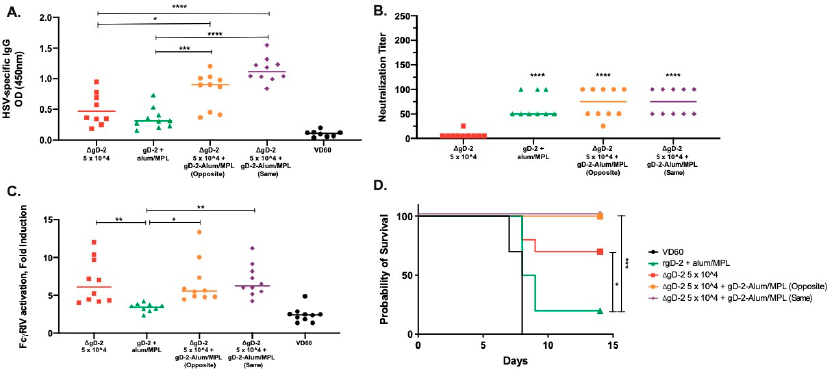
Figure 6. The generation of neutralizing antibody enhances protection by low-dose ∆ gD-2. Female C57BL / 6 mice were subcutaneously vaccinated twice, three weeks apart with 5 × 10 4 pfu / mouse of ∆ gD-2, 5 µ g gD-2-Alum / MPL or a combination of both vaccines delivered on opposite flanks (opposite) or at the same site (same). One week after the second vaccination, mice were retro-orbitally bled and serum was assessed for ( A ) total HSV-specific IgG by ELISA, ( B ) neutralizing titer and ( C ) Fc γ RIV activation. ( D ) Three weeks after the second vaccination, mice were challenged on the skin with a 10 × LD90 dose of HSV-2 (SD90). Percentage survival is shown. n = 5 mice per group, two independent experiments. (A–C) * p < 0.05, ** p < 0.01, *** p < 0.001, **** p < 0.0001 by ANOVA. For survival curves, * p < 0.05, *** p < 0.001 by